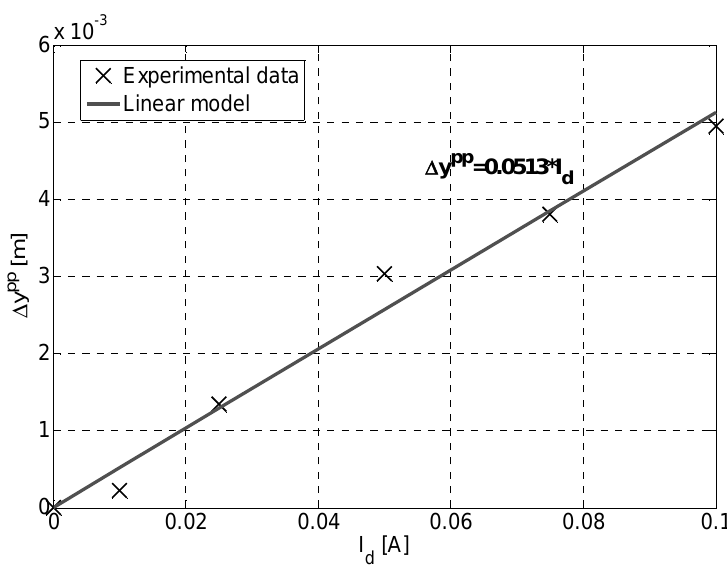
Figure 9. The device response in case of sinusoidal driving current @4.1 Hz and B DC = 37.1 mT.